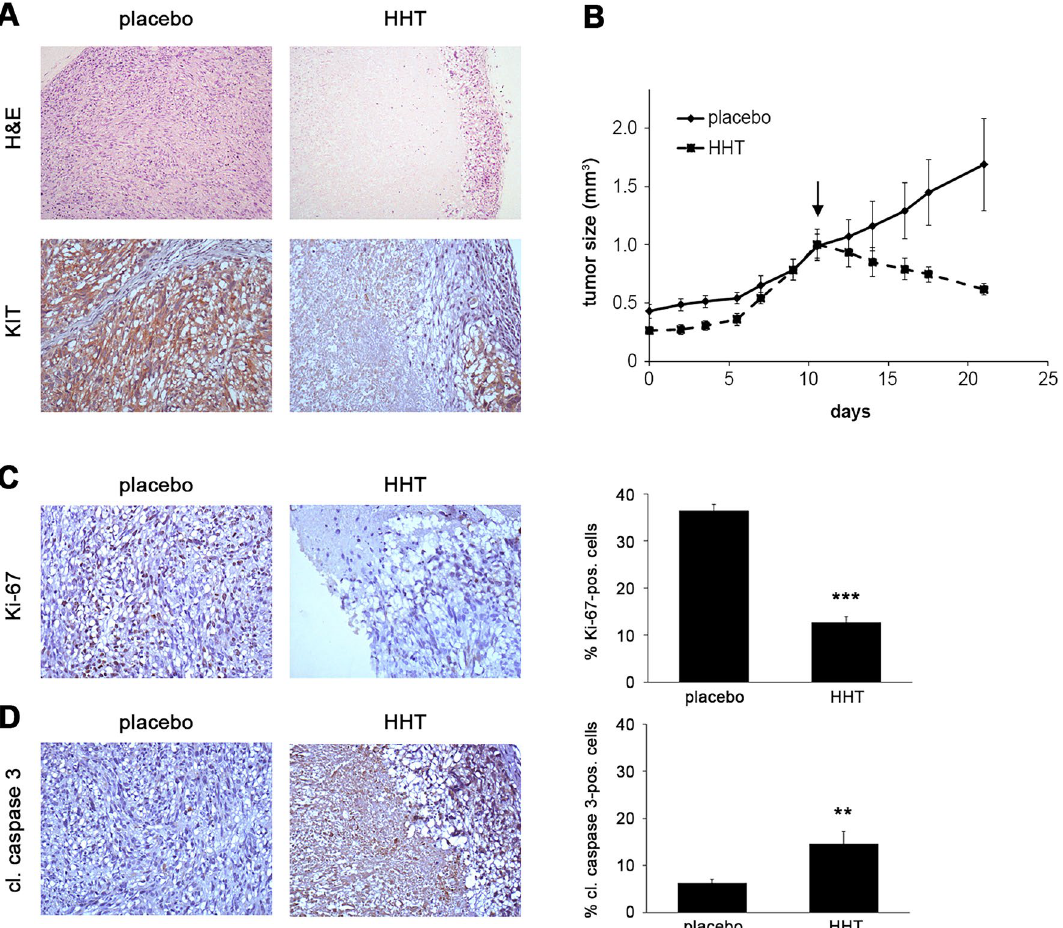
Figure 5. HHT is effective in a GIST xenograft. (A) Histopathologic response (hematoxylin and eosin, H&E; 10X; upper panels) and immunohistochemical staining for KIT (20X; lower panels) of GIST-T1 xenografts after treatment with HHT in comparison to placebo-treated controls. (B) Relative tumor volume of GIST-T1 xenografts since inoculation and over the course of a 21-day treatment with vehicle (solid line) or HHT (dashed line). Measurements represent the average of four tumors per group treated either with placebo or 2 mg/kg HHT (reduced to 1 mg/kg at day 7) for 21 days. Arrow indicates start of treatment. (C,D) Immunohistochemical staining for (C) Ki-67 (20X; upper panels) and (D) cleaved caspase 3 (20X; lower panels) of GIST-T1 xenografts treated with HHT or placebo control. Graphs represent mean and standard error of positive cells in 10 high power fields (HPF; 400-fold magnification), with an average of 245 cells counted per HPF. Columns, mean + SE; **, p ≤ 0.01 in comparison to control; ***, p ≤ 0.001 in comparison to placebo control (Student’s t-test,